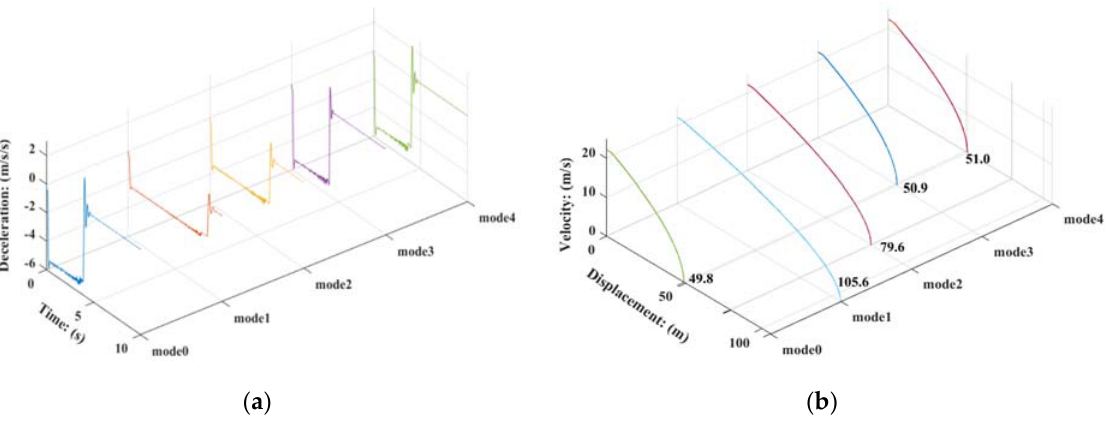
Figure 21. Braking efficiency of mode 0 and complete failure of mode 1 ~ 4 . ( a ) Deceleration of truck body; ( b ) velocity-displacement curves of truck body.